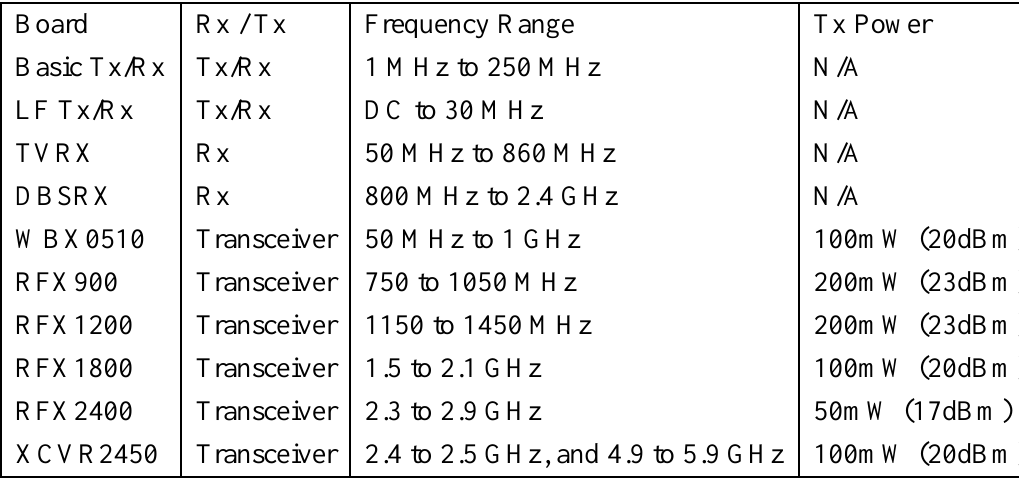
Table 1. USRP daughterboard list with